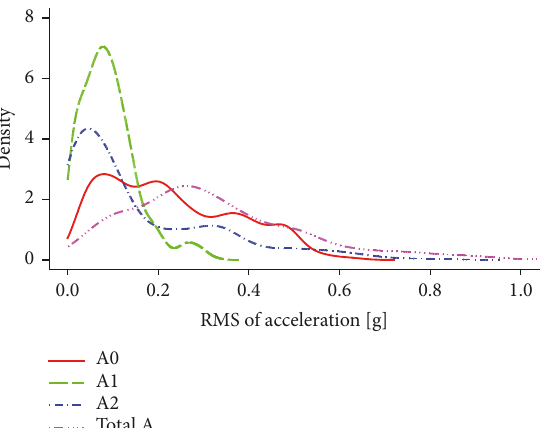
Figure 7: Density distribution of the RMS of acceleration experi- enced for all sessions.